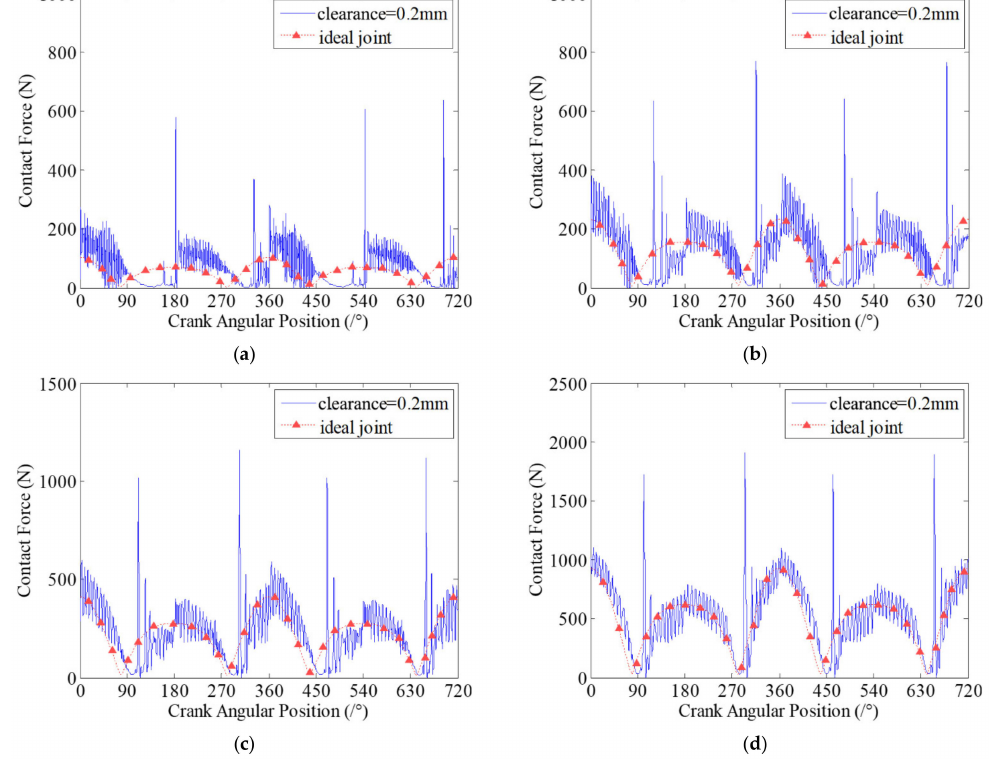
Figure 12. Contact forces in revolute clearance joint A for different driving speeds. ( a ) 200